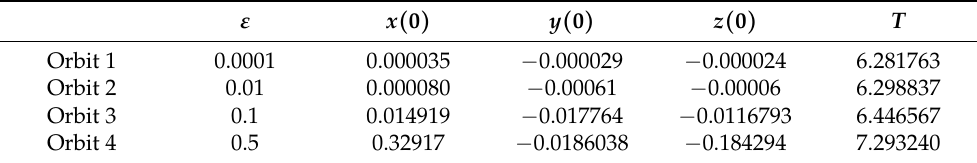
Table 1. Initial conditions and periods for ε = 0.0001,0.01,0.1 and 0.5.